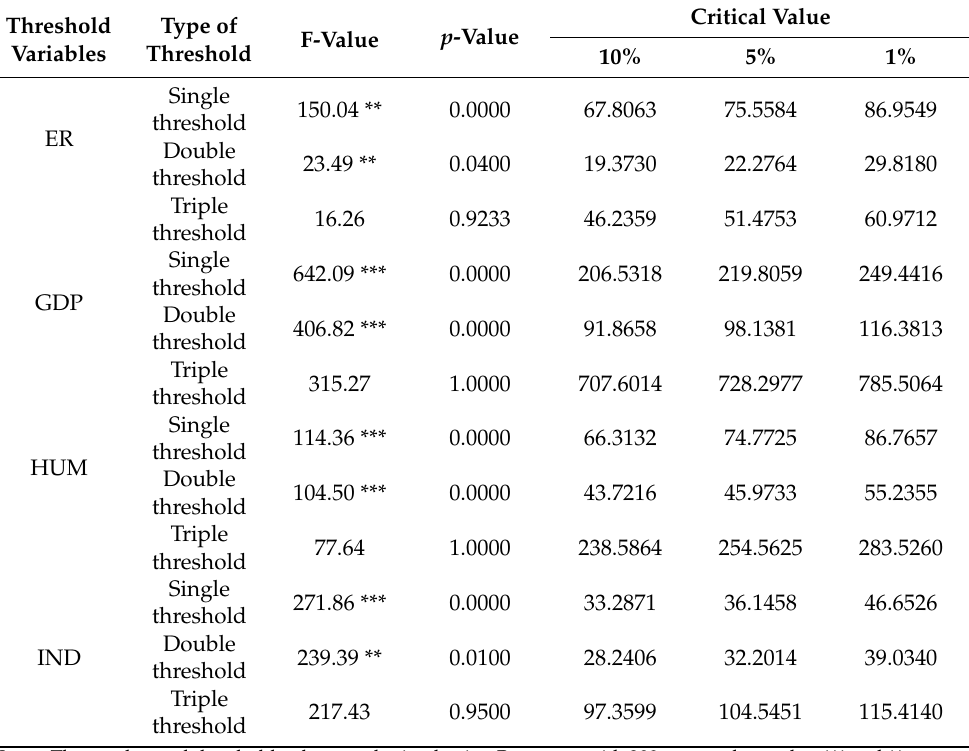
Table 3. Results of the panel threshold effect